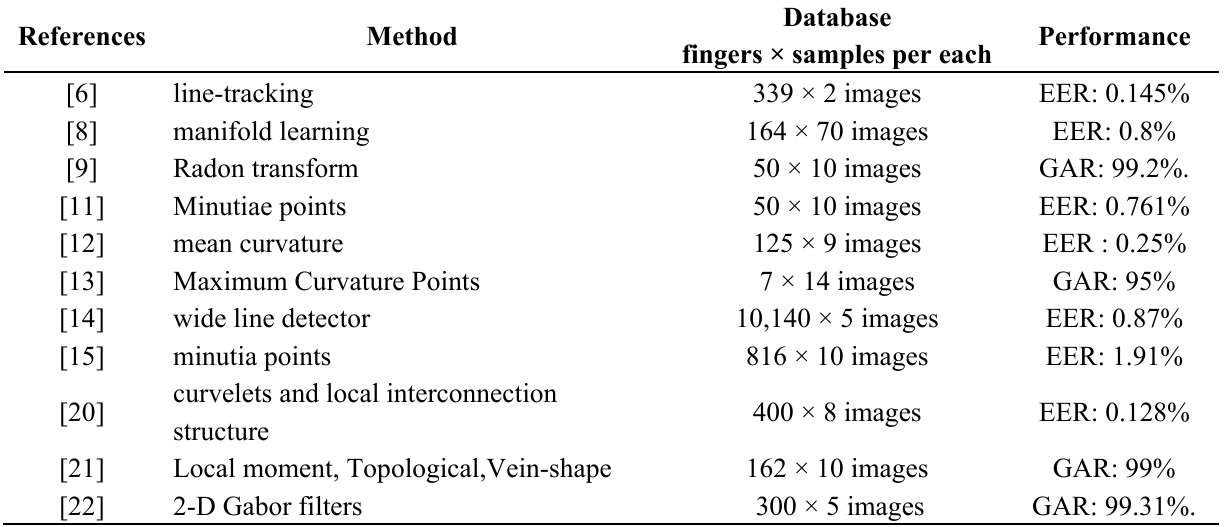
Table 1. Methods for personal authentication using finger vein